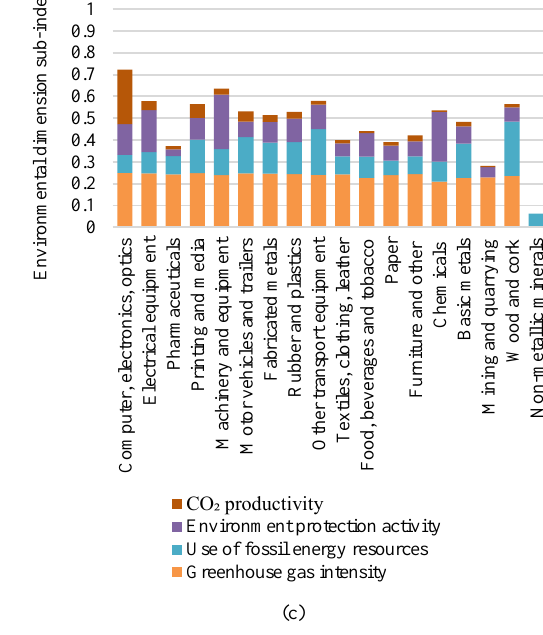
Fig. 2. Results for the a) economic, b) technical, c) environmental dimension sub-indices of